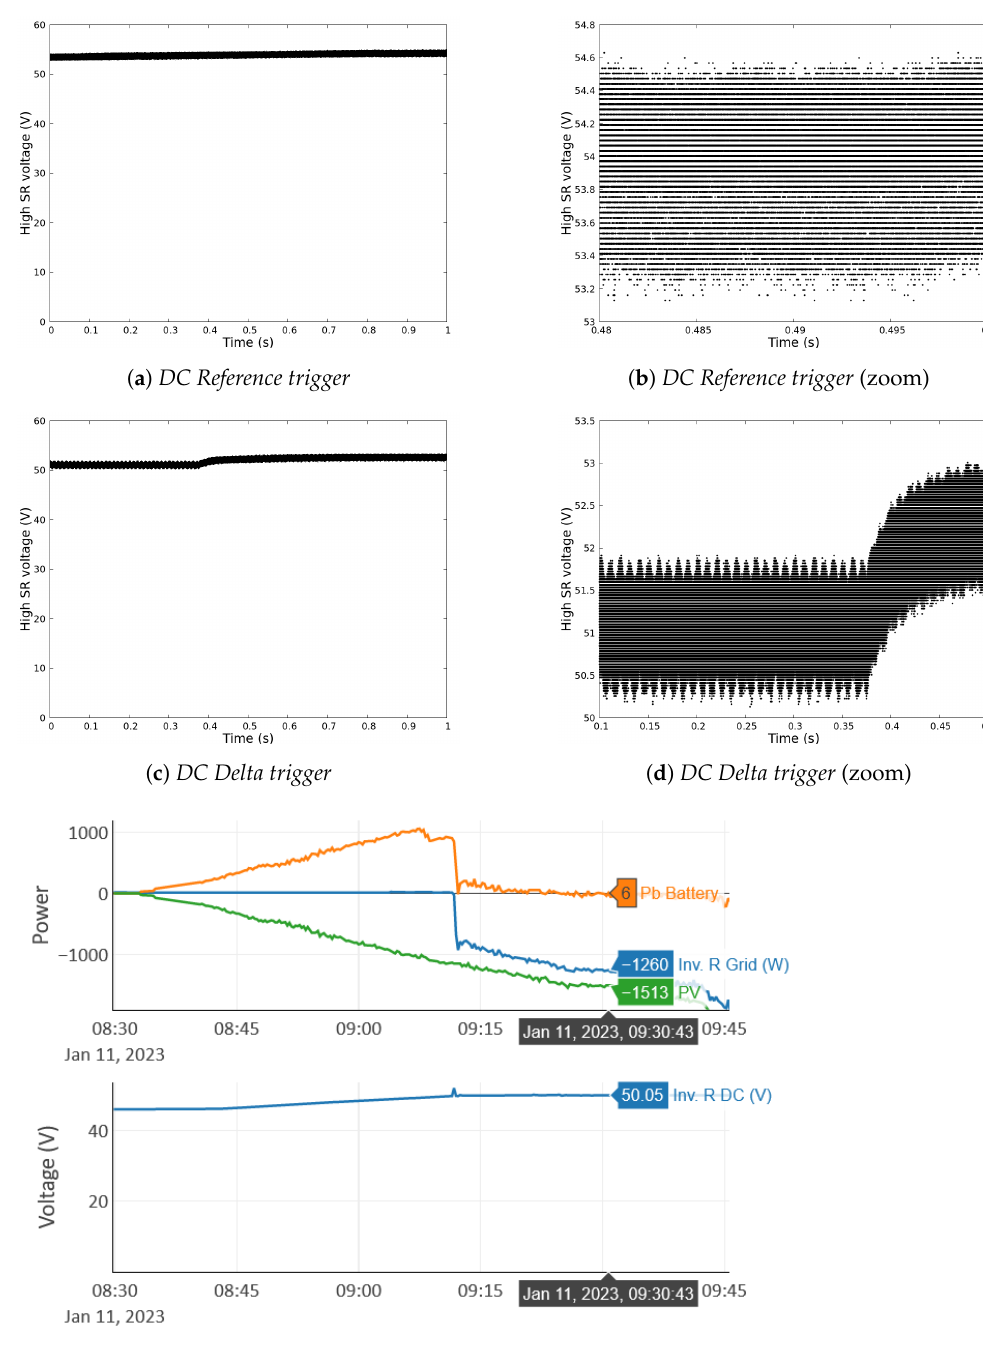
Figure 9. Triggered events in the real micro-grid ( a , c ) associated with DC bus voltage overshoot ( e